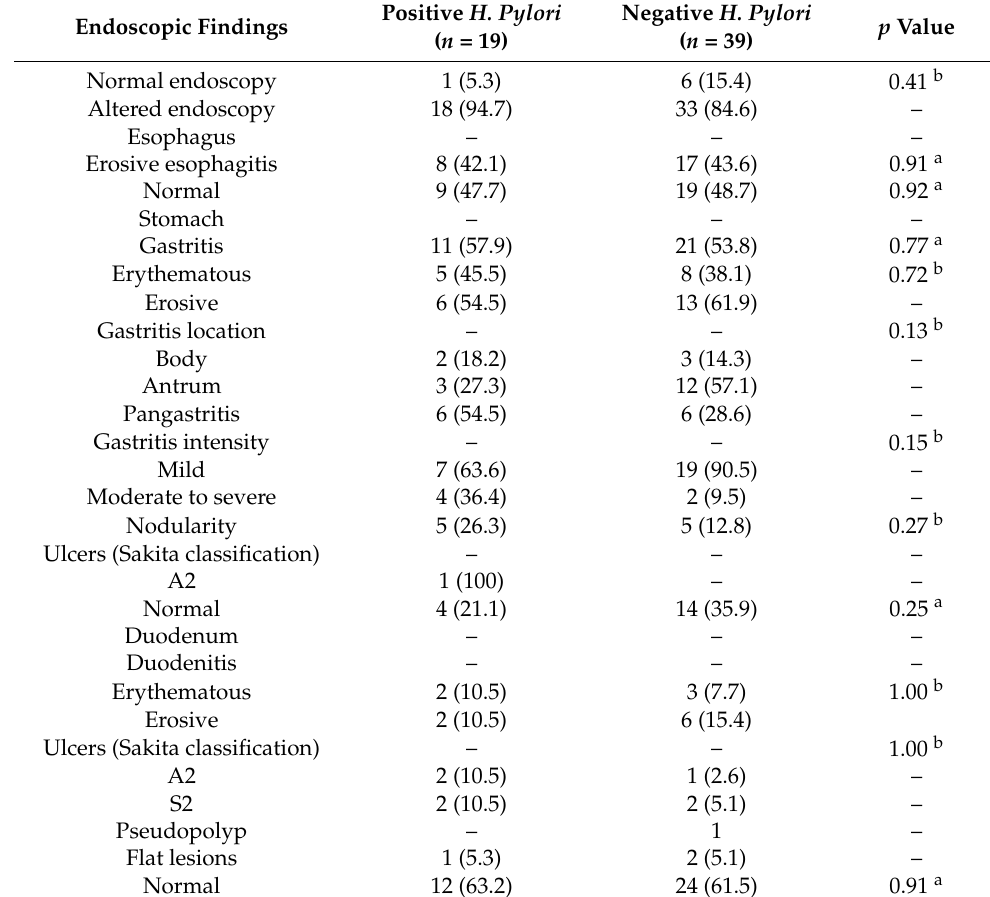
Table 3. Comparison of Endoscopic Findings According with the Presence of H. pylori in Patients with CD.